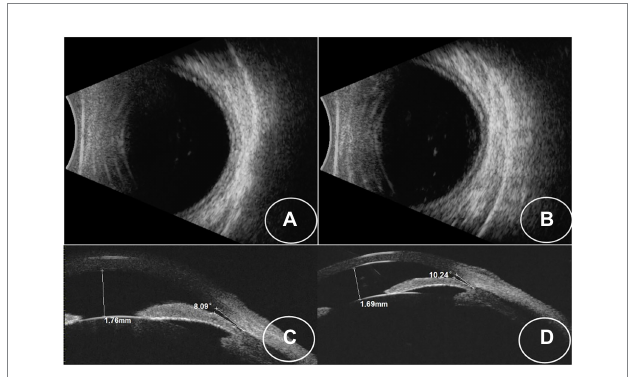
FIGURE 2 (A,B) B-scan images showing choroidal effusion in both eyes. (C,D) UBM images showing that the iris-lens diaphragm is pressed against the anterior chamber angle in both eyes.